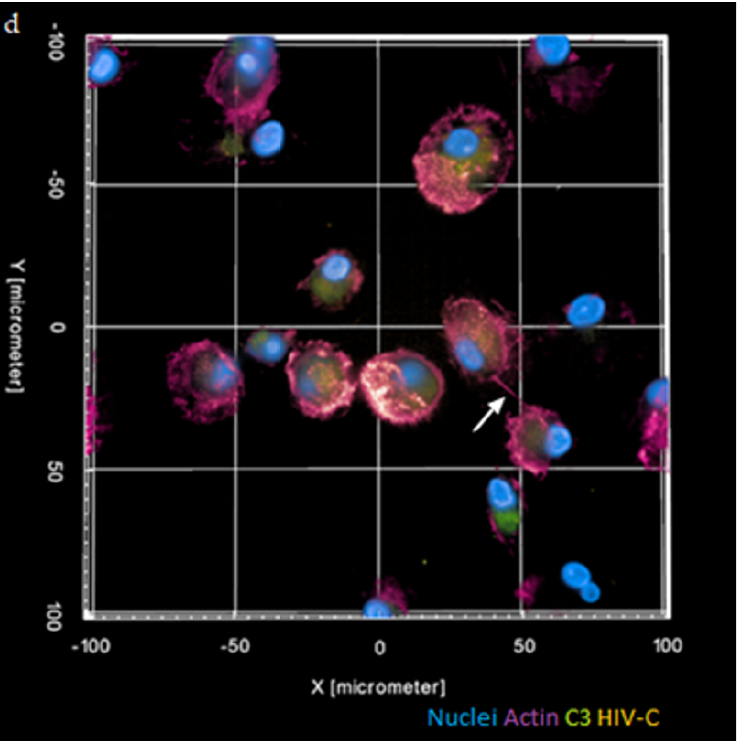
Figure 4. Treatment of HIV-C-infected DCs and DC/CD4 + T-cell co-cultures with antagonists of anaphylatoxin receptors C3aRI and C5aRI/II. ( a ) Quantification of TNTs on HIV-C-loaded DCs and DC/CD4 + T-cell co-cultures at 7 dpi with/without treatment with C3aRi and C5aRi.